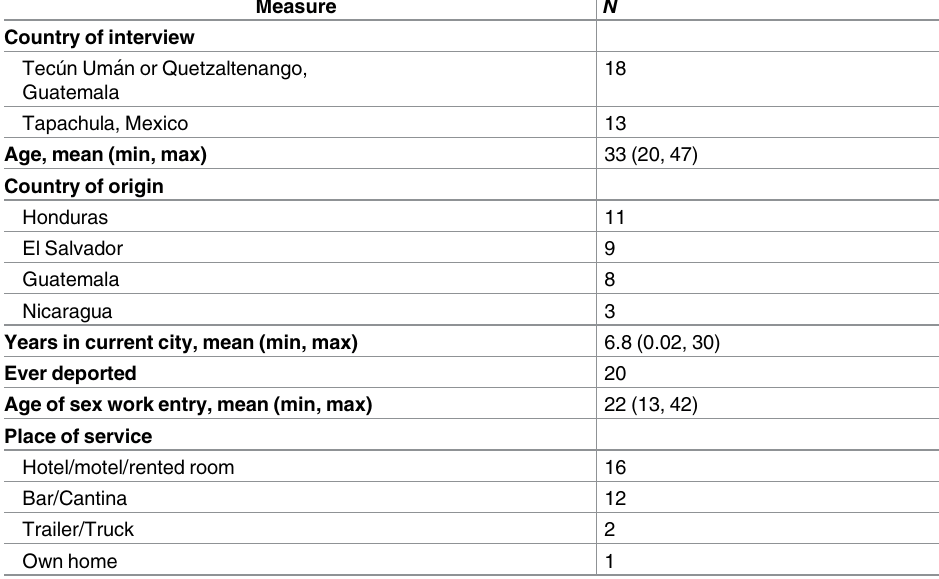
Table 1. Socio-demographic characteristics of international migrant sex workers (N = 31) in the Mexico-Guatemala